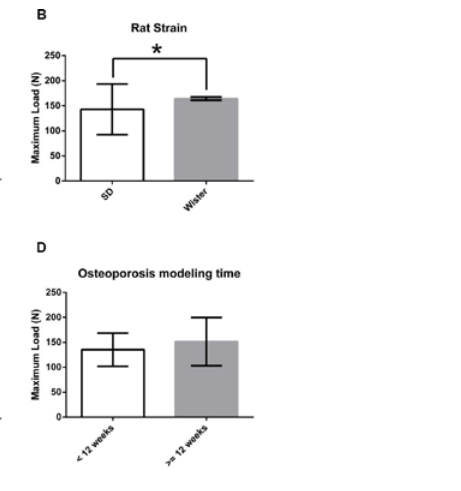
Fig 3. Identification of factors affecting osteoporotic fracture healing in OVX rats at D84 PF. (A) Maximum load of fractured femurs in OVX rats with closed fractures was significantly lower than that of OVX rats with open fractures at D84 PF (p < 0.05). (B) Maximum load of fractured femurs in SD rats was significantly different from that of Wister rats at D84 PF (p < 0.05). (C) Studies were divided into two groups according to the age of the rats when ovariectomized. Maximum load of OVX rats ovariectomized at < = 12 weeks old was lower than that of OVX rats ovariectomized > 12 weeks old at D84 PF (p < 0.05). (D) Studies were divided into two groups according to the length of time from ovariectomy to femur fracture surgery, < 12 weeks or > = 12 weeks. There was no significant difference in femur maximum load between these two groups at D84 PF (p > 0.05).